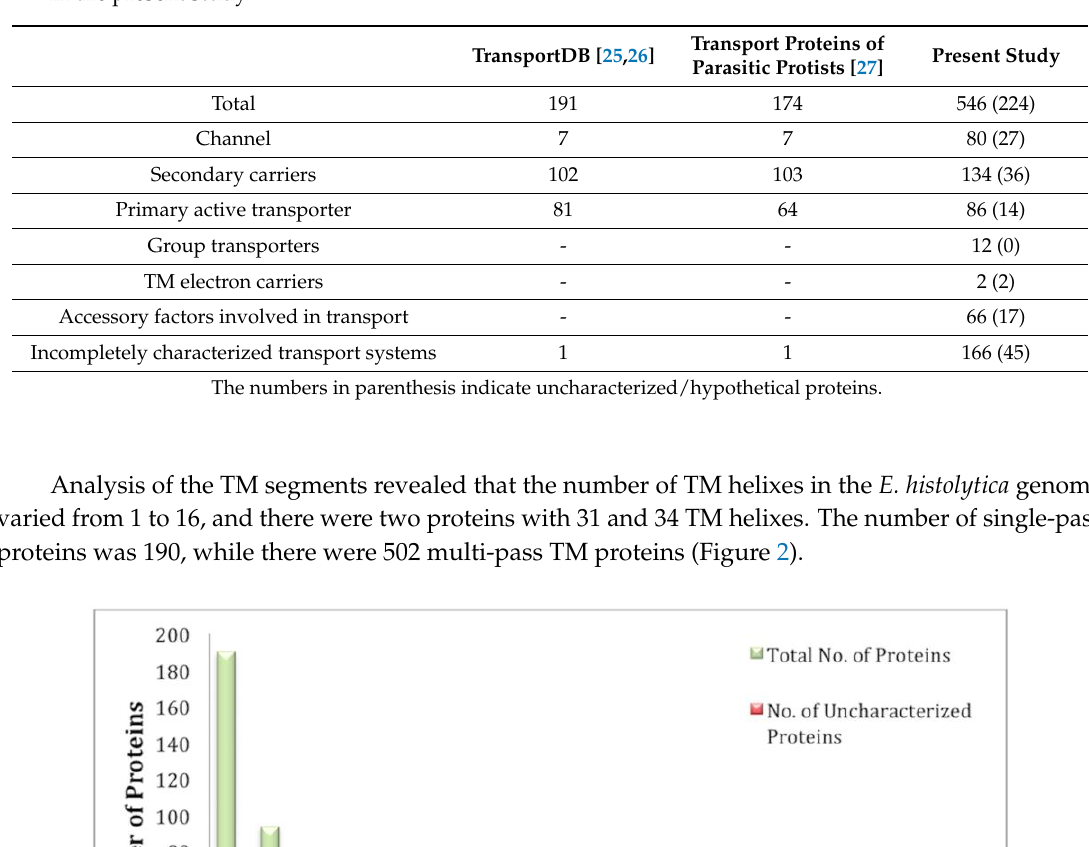
Table 2. Distribution of the TM transporters based on the transporter classification database into class and subclass in E. histolytica .